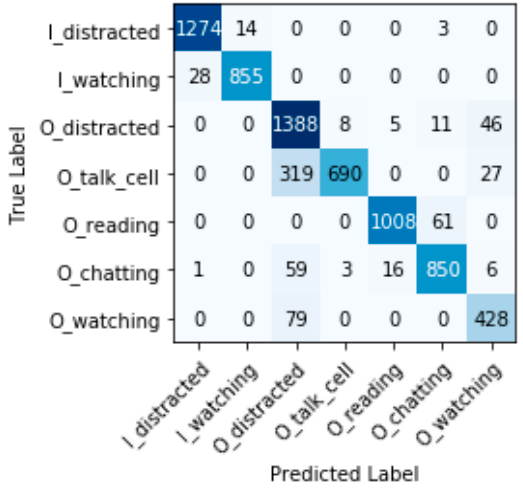
Figure 14. Confusion matrix Inception-v3.